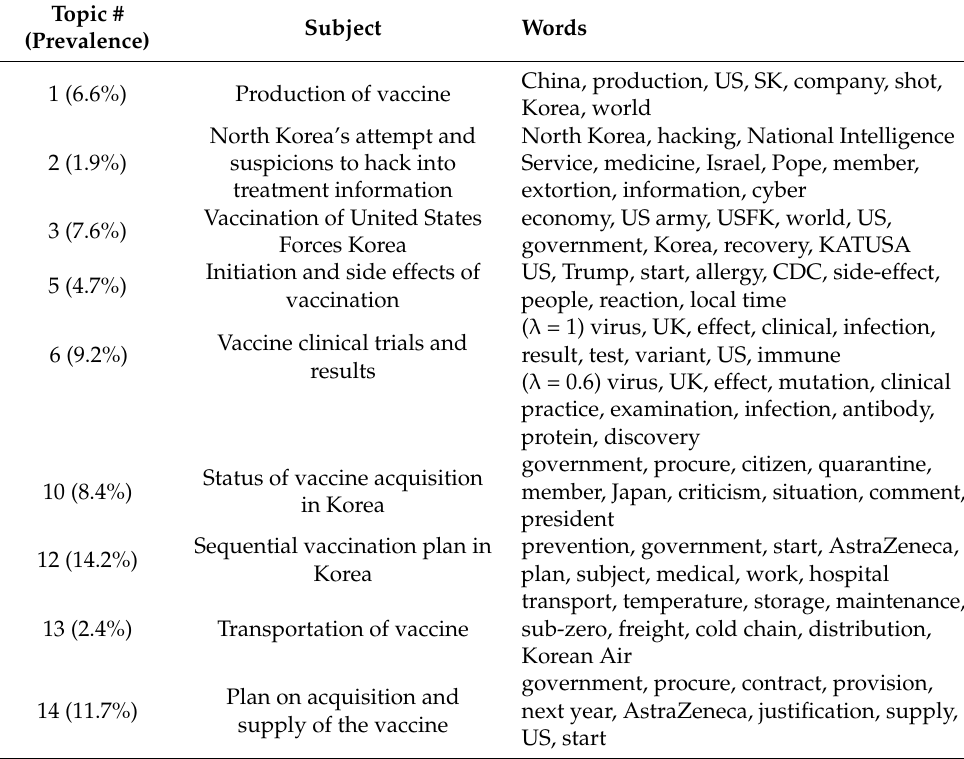
Table 3. Topics drawn from Phase 2 (18 December 2020–25 February